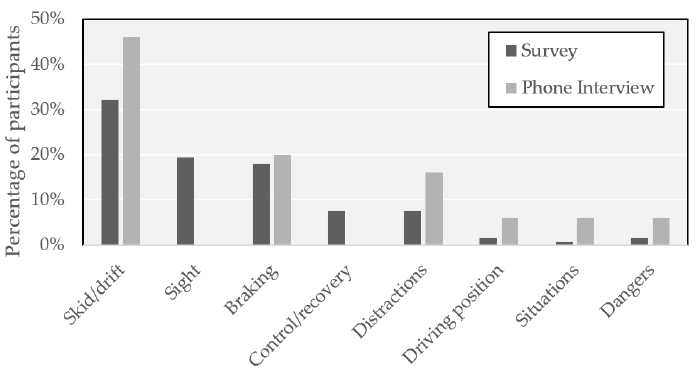
Figure 9. Most important thing learned: survey vs. phone interview.